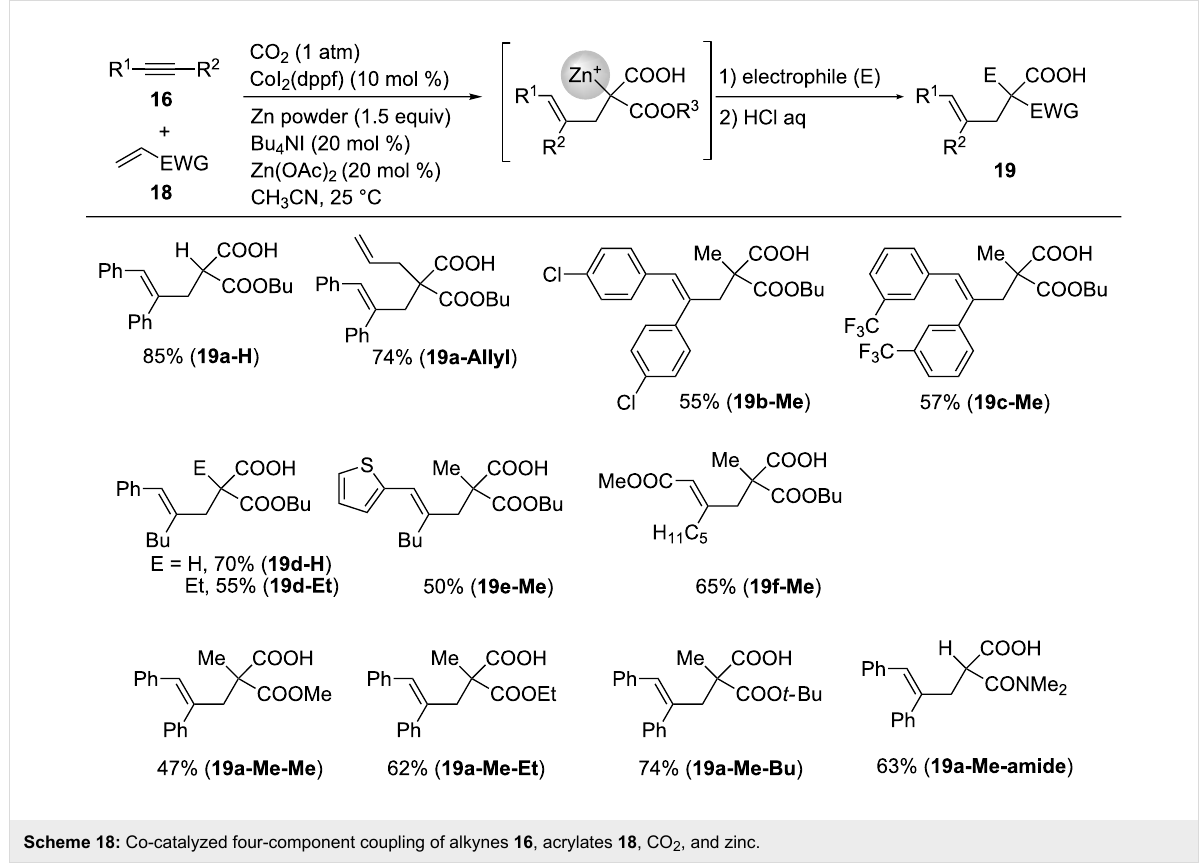
Scheme 18: Co-catalyzed four-component coupling of alkynes 16 , acrylates 18 , CO 2 , and zinc.